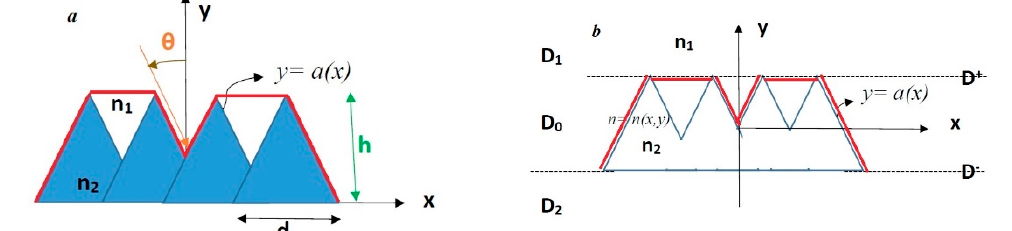
Figure 1. ( a ) Notation and Cartesian coordinate system for a typical grating, triangular morphology (blue) and trapezoidal scheme (red). ( b ) Definition of the spatial domains D + , D − , D 1 and D 2 .